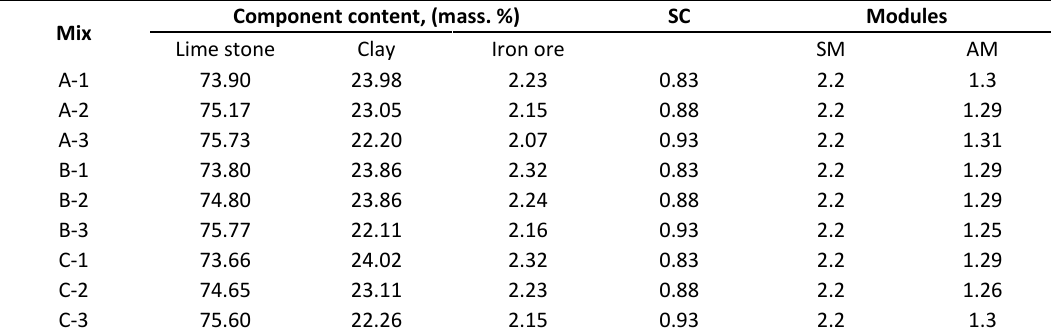
Table 3. Composition and characteristics of mixes for obtaining cementclinkers